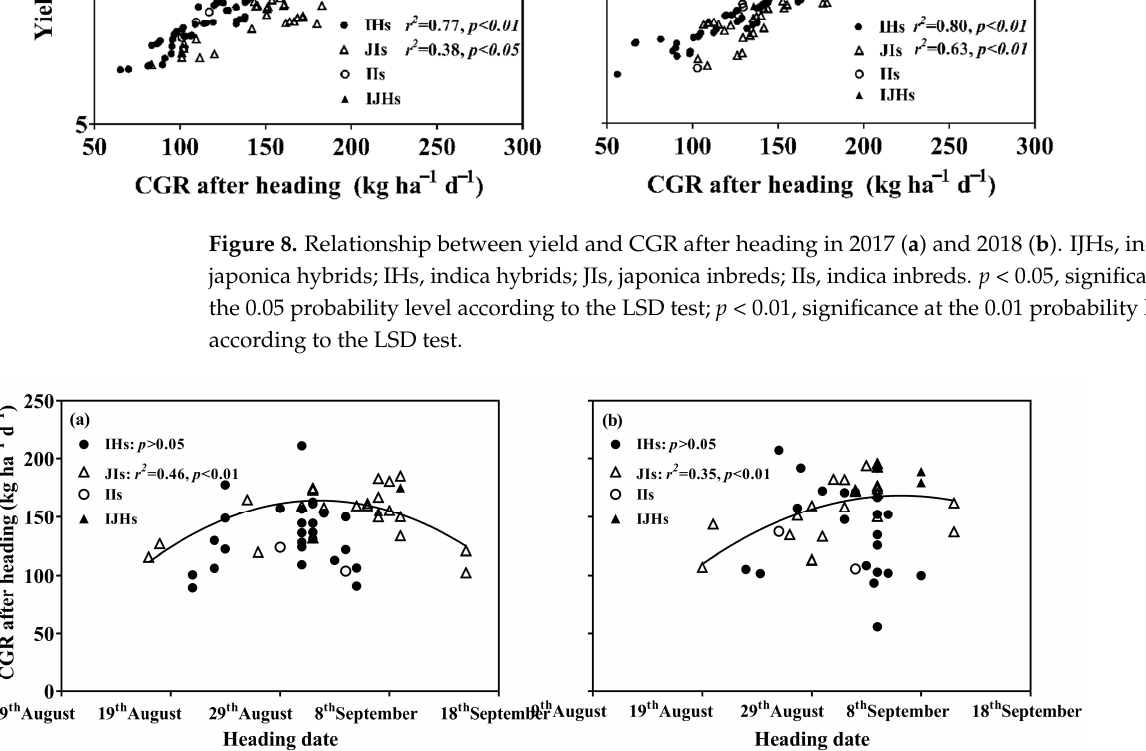
Figure 9. Relationship between CGR after heading with heading date in 2017 ( a ) and 2018 ( b ), respectively. IJHs, indica-japonica hybrids; IHs, indica hybrids; JIs, japonica inbreds; IIs, indica inbreds. p > 0.05, not significant at the 0.05 probability level according to the LSD test. p < 0.01, significant at the 0.01 probability level according to the LSD test.